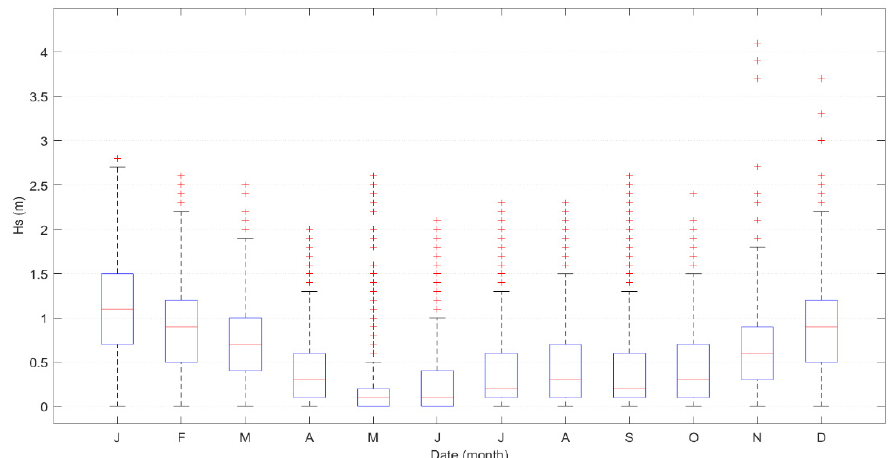
Figure 10. Box-and-whisker plot (upper panel) and time-series plot (lower panel) of H s from MOV. Red line inside the box of the box whisker plot shows the monthly median, box edges represent the 25th and 75th percentiles, the whiskers extend to the most extreme data points not considered outliers, while the red “+” marker symbol represents the outliers.